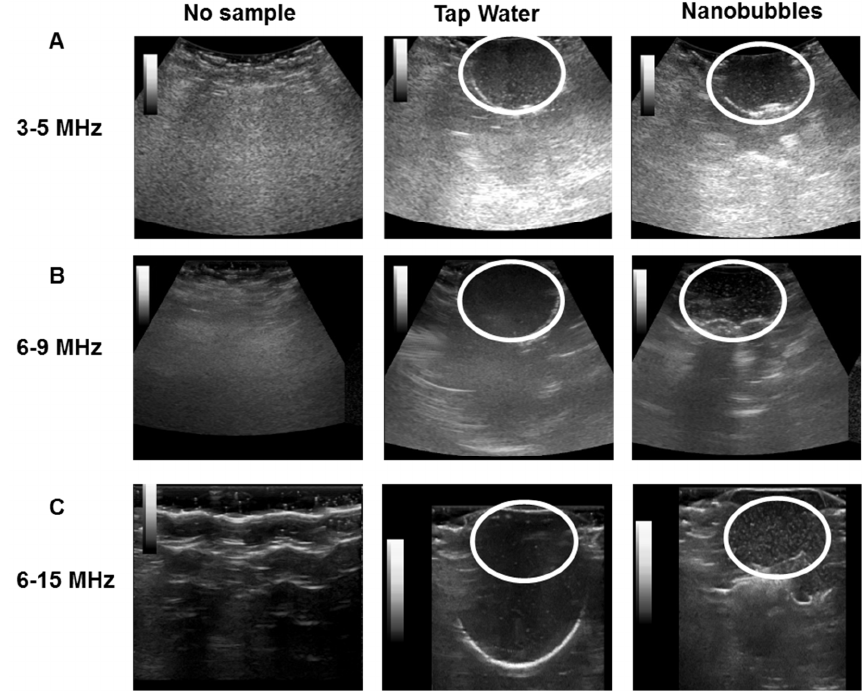
Figure 4. Ultrasound images of ONBs. No sample, tap water, and nanobubbles were compared. ( A ) shows images with a 3 to 5 MHz transducer. ( B ) shows images for a 6 to 9 MHz transducer. ( C ) shows images with a 6 to 15 MHz transducer.